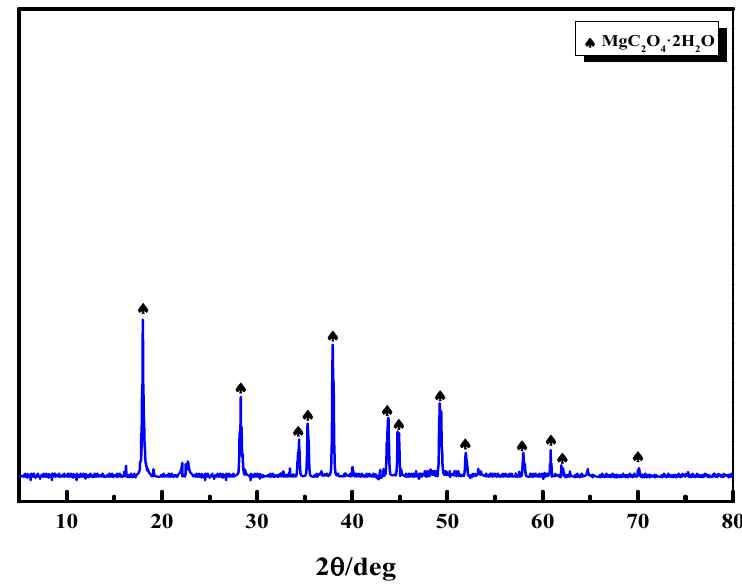
Figure 11. XRD patterns of MgC 2 O 4 .2H 2 O precipitate.